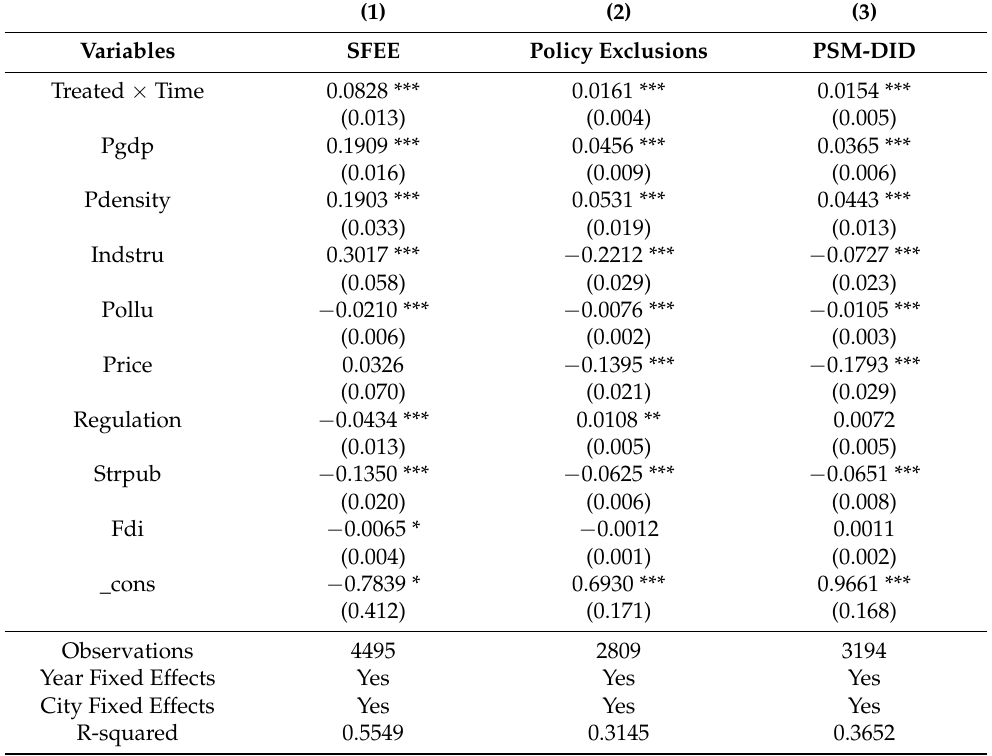
Table 4. Robustness